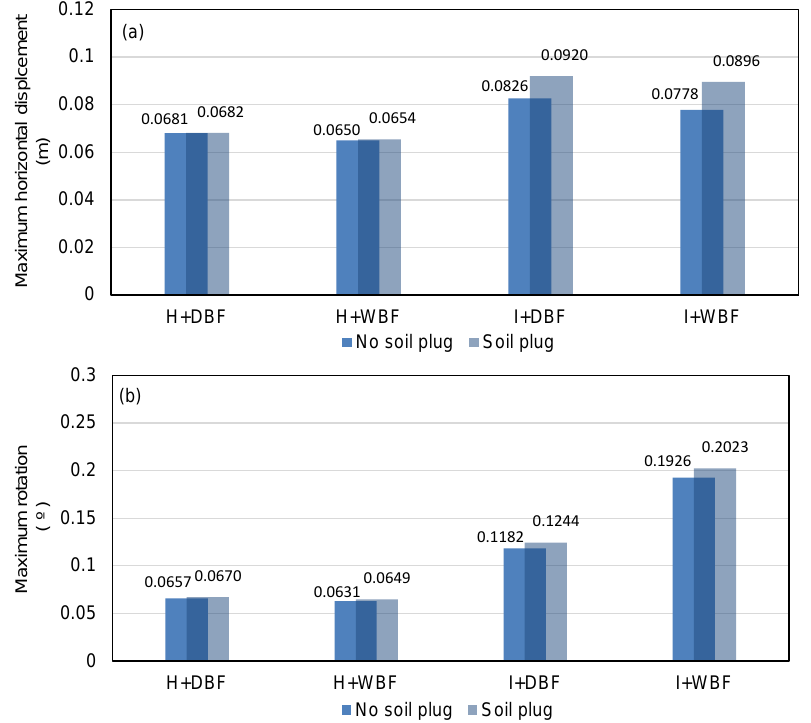
Figure 13. The maximum horizontal displacement and rotation of bucket foundations in 80% relative density liquefiable seabeds: ( a ) maximum horizontal displacement; ( b ) maximum rotation. The maximum rotations of DBF and WBF in 80% relative density seabed soil are shown in Figure 11b. For DBF, the maximum rotation of bucket foundation increased by 2.0% in horizontal ground and by 5.2% in inclined ground due to the presence of soil plug. For WBF, it increased by 2.9% in horizontal ground and by 5.0% in inclined ground. In the dense seabed, the influence of soil plug was less significant compared with in looser sea- bed. 4. Seismic Response of Bucket Foundation with Different Reinforcement Types It is clear from the aforementioned analysis that the existence of soil plug has a neg- ative influence on the seismic performance of OWT on bucket foundations in liquefiable seabeds. Therefore, it is important to evaluate the potential improvement in performance when various reinforcement methods are adopted, especially for the more unfavorable inclined seabed conditions. The influence of three reinforcement types for the wide and deep bucket foundations was studied (simulations 6, 8 and 17–28 in Table 4).